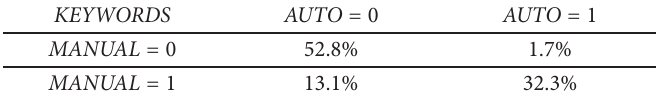
Table 9. Prediction performance of the automatic KEYWORDS indicator